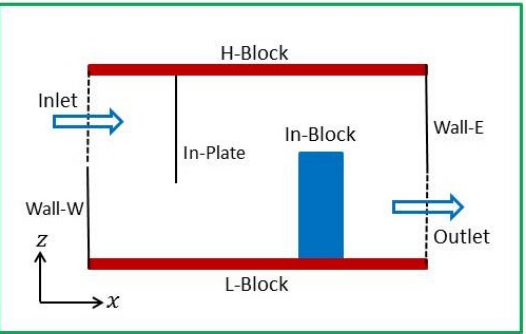
Figure 4. Geometry and contents of a 2D computational domain with steady turbulent flow of air and heat exchange.